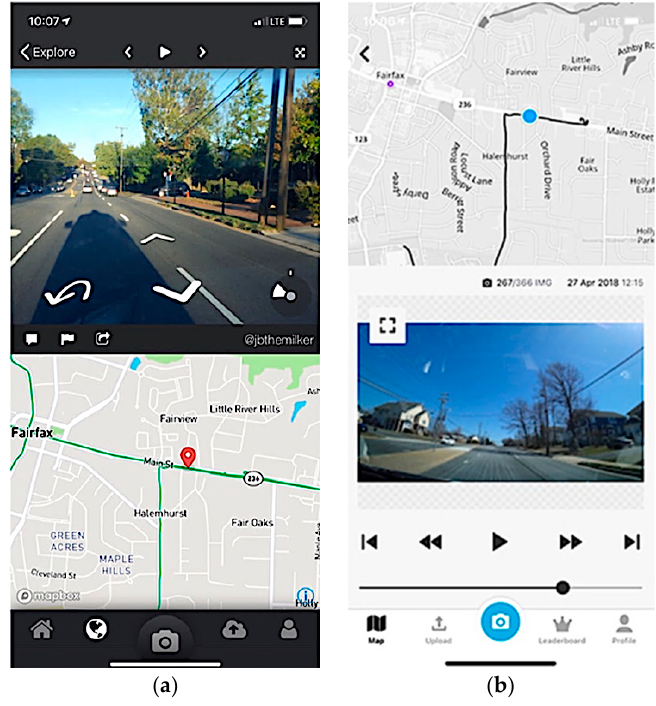
Figure 1. Graphical user interfaces of ( a ) Mapillary and ( b ) OpenStreetCam (OSC).